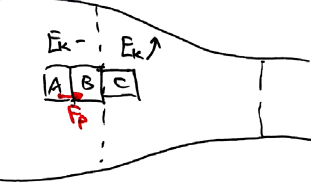
FIG. 4. A force diagram, drawn by a teacher participant (T3), of fluid elements at the borderline of regions I and